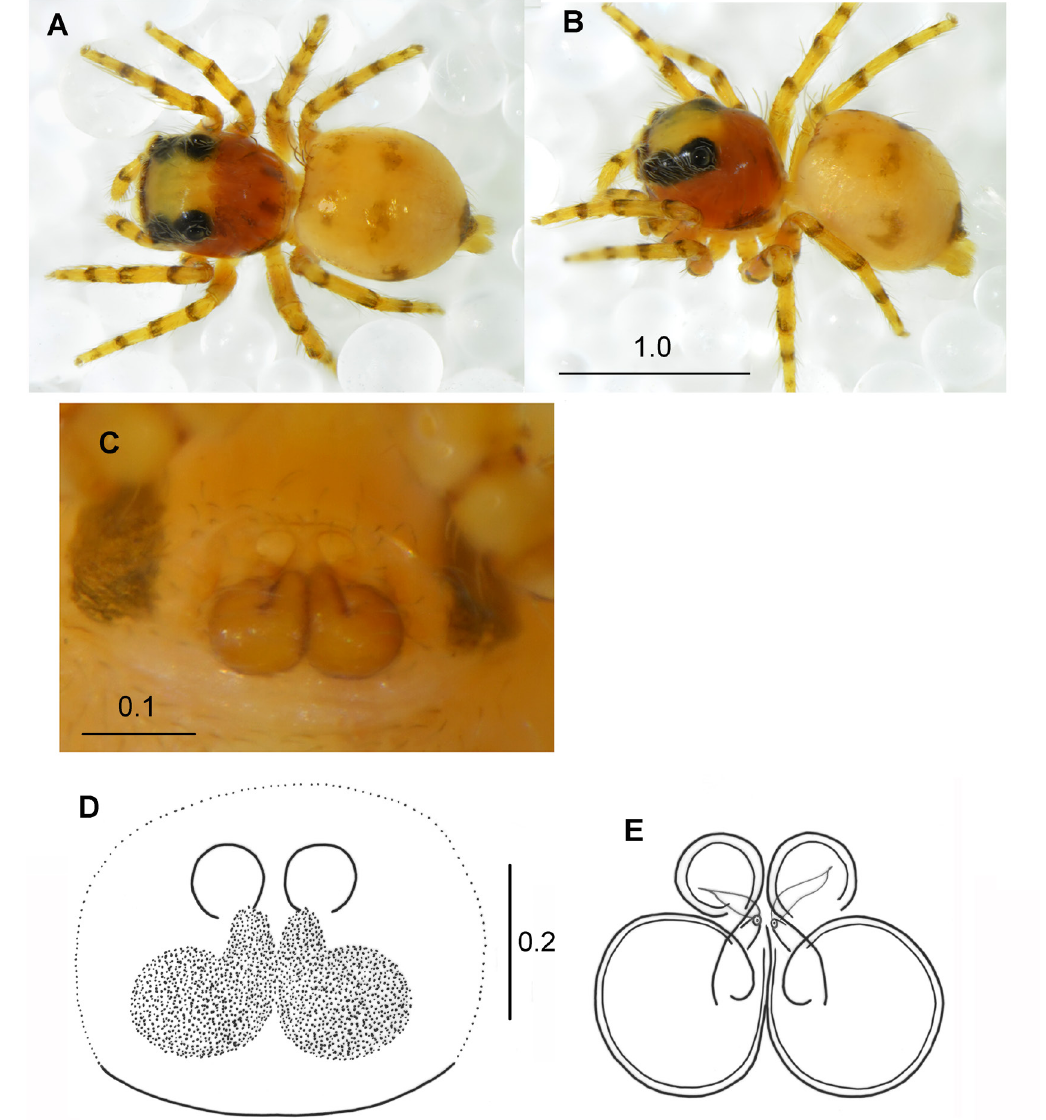
Fig. 63. Sphericula globulifera gen. et sp. nov., holotype, ♀ (MNHN). A . Habitus, dorsal view. B . Habitus, dorsolateral view. C–D . Epigyne. E . Internal structure of